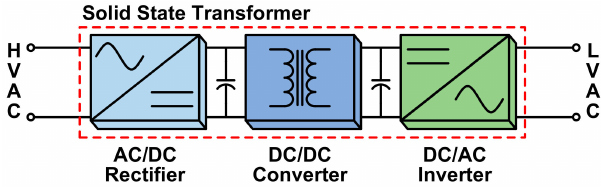
Figure 1. The block diagram of solid-state